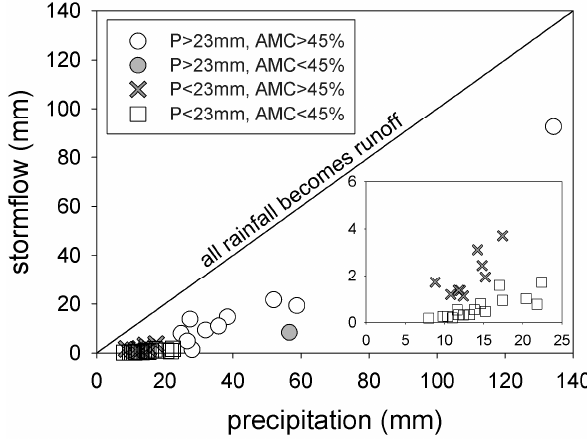
679 Figure 9. Total stormflow as a function of total precipitation for all events. P: Precipitation; AMC: 680 Fig. 9. Total stormflow as a function of total precipitation for all average Antecedent Moisture Content measured at 0-30 cm. In the inset: zoom for the relation at low 681 events. P : Precipitation; AMC: average Antecedent Moisture Con- precipitation values. 682 tent measured at 0–30cm. In the inset: zoom for the relation at low 683 precipitation